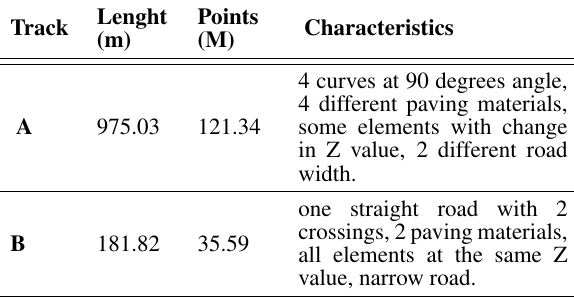
Table 1. Main characteristics of the two tested